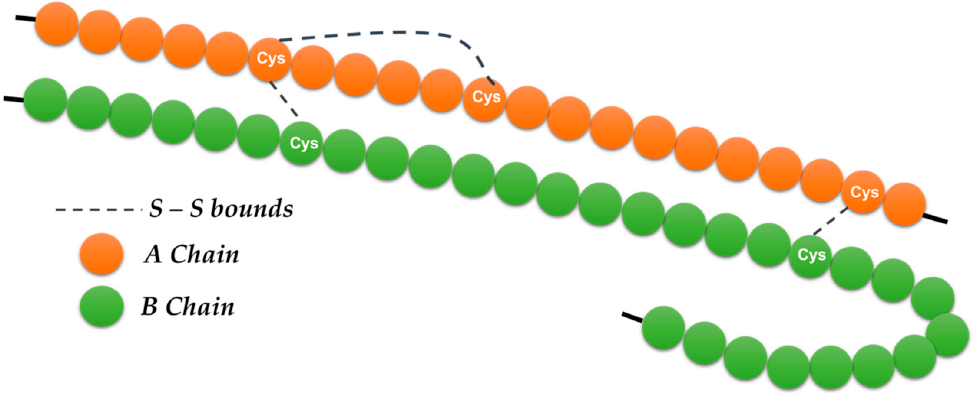
Figure 2. Insulin is a polypeptide hormone, relatively “small”, consisting of two peptide chains (A and B) containing a total of 51 amino acids, 21 amino acids in the A chain and 30 amino acids in the B chain. Of the 20 amino acids, it lacks the amino acids tryptophan (Try) and methionine (Met). It has three disulfide bridges (-S-S-), of which two hold the two chains. Neither of the two chains separately exhibits any physiological activity, and therefore the action of insulin is due to the overall configuration of its molecule (tertiary structure) and not to its individual components’ peptides or amino acids.